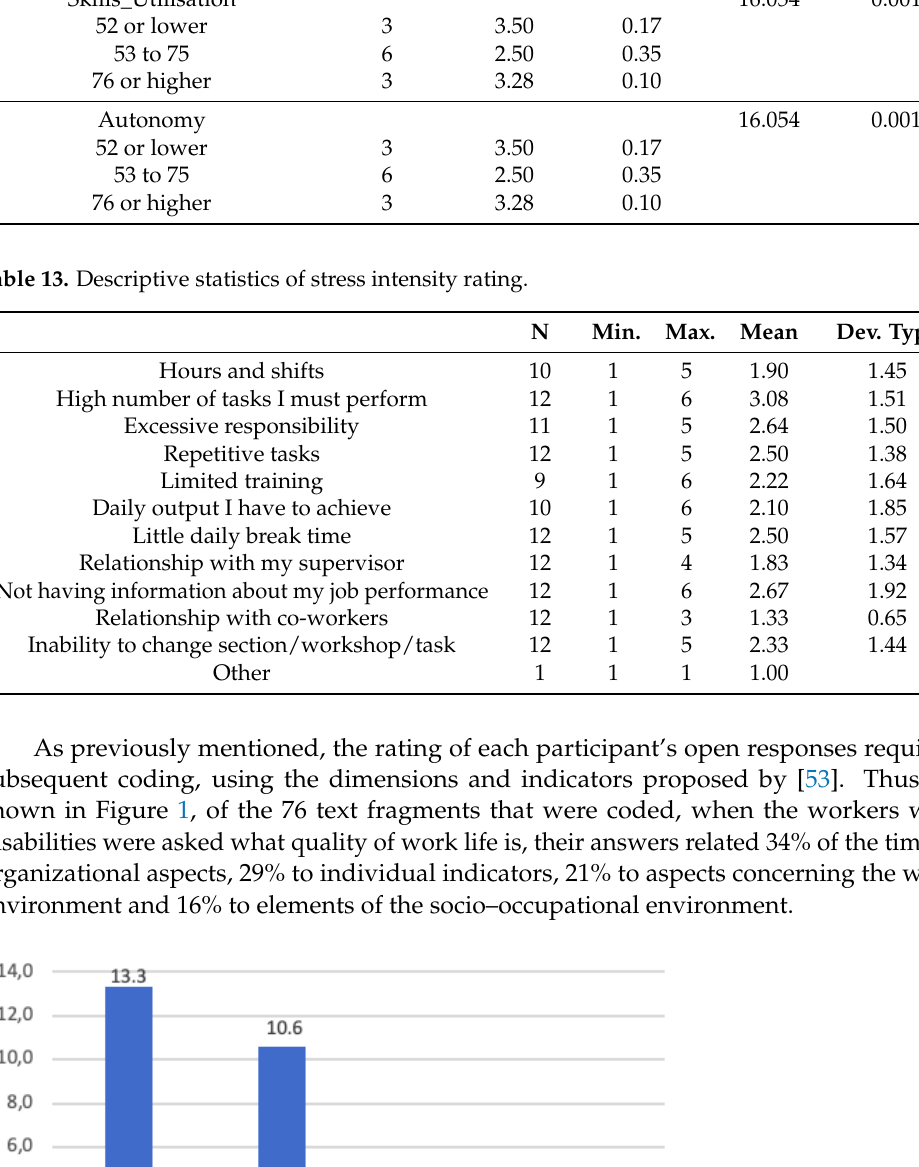
Table 14. Descriptive statistics of stress intensity rating.